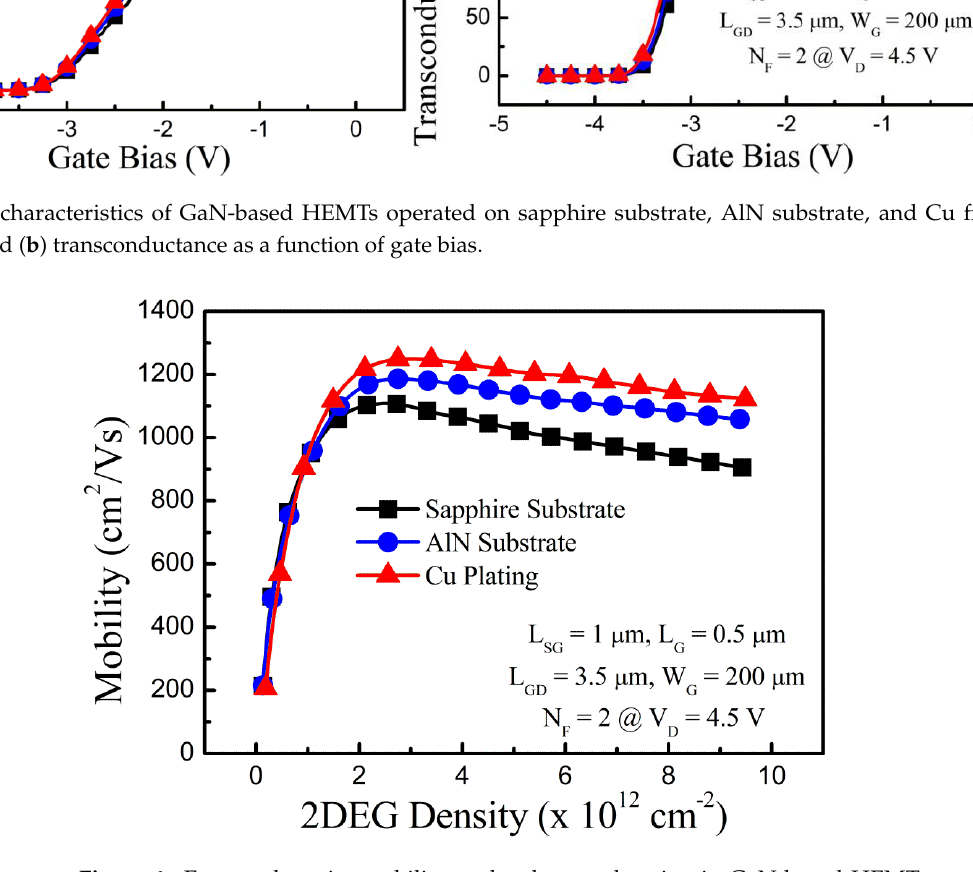
Figure 4. Extracted carrier mobility under the gated region in GaN-based HEMTs operated on sapphire substrate, AlN substrate, and Cu film. Carrier mobility as a function of 2DEG density.